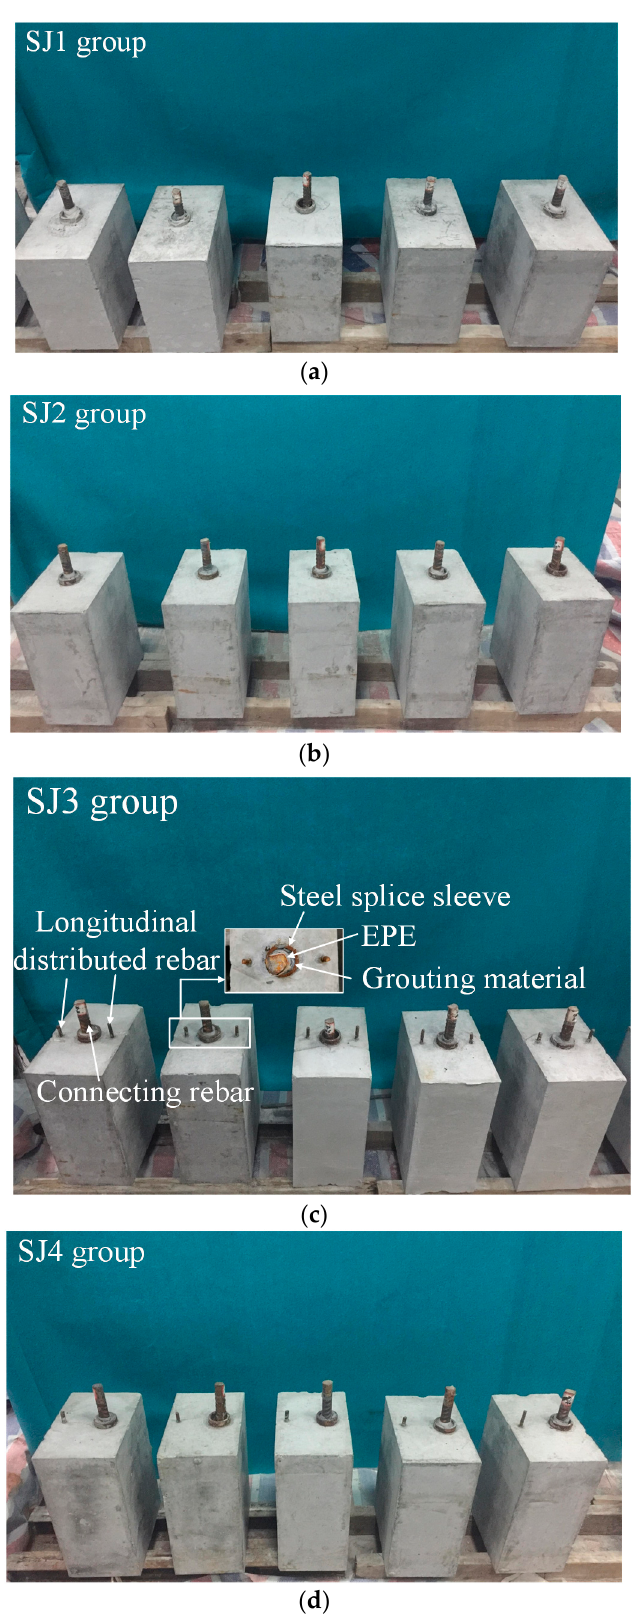
Figure 2. The physical diagram of the concrete specimens. ( a ) SJ1 group, ( b ) SJ2 group, ( c ) SJ3 group, ( d ) SJ4 group.